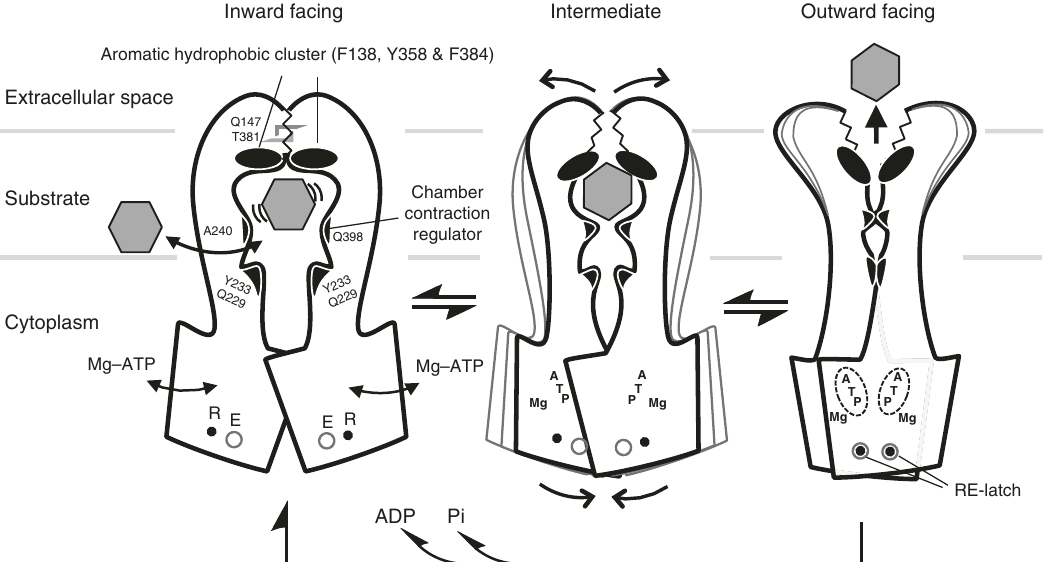
Fig. 6 Proposed model for transport mechanism of CmABCB1. Schematic drawing of conformational change between the inward- (left) and the outward- facing (right) CmABCB1. An expected intermediate state is depicted in the center panel. The characteristic devices indispensable for the mechanics of transport are